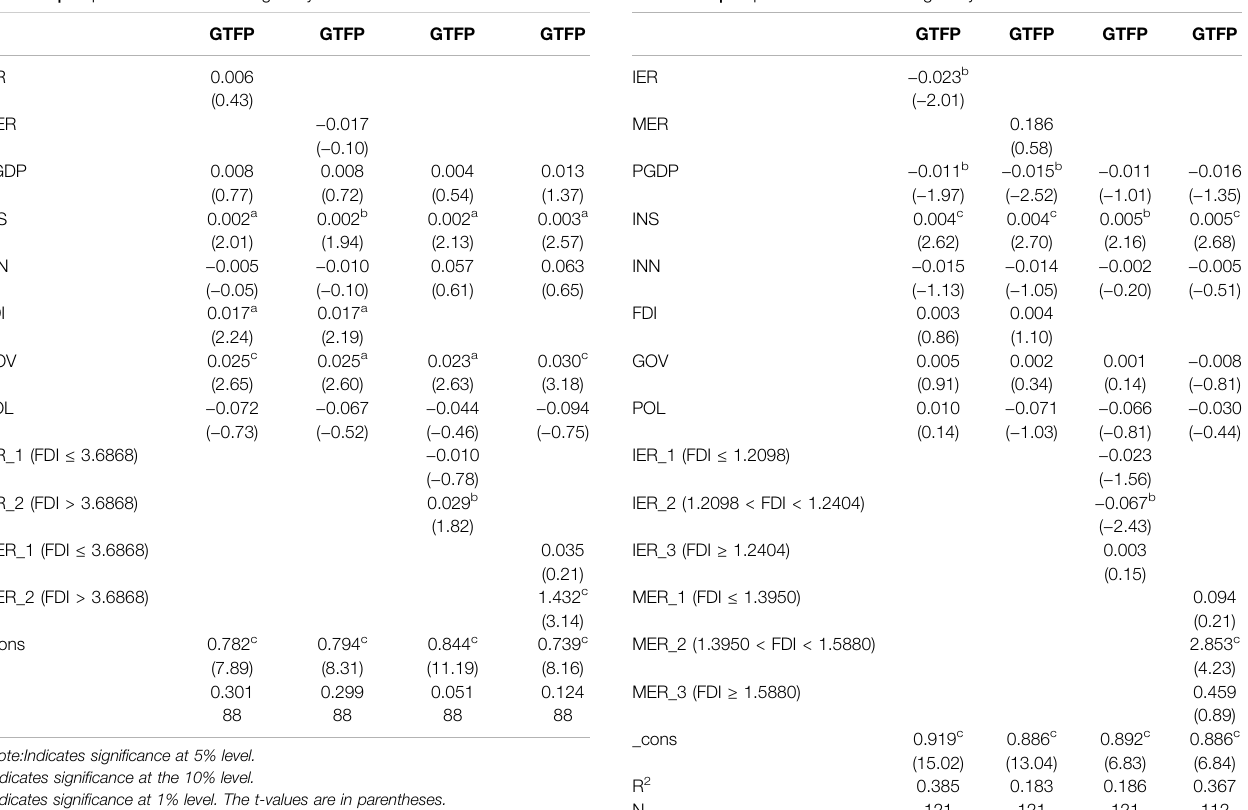
TABLE 9 | Empirical results of heterogeneity test in central China. TABLE 10 | Empirical results of heterogeneity test in western